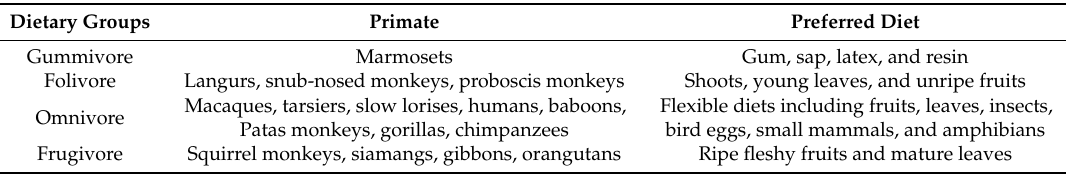
Table 1. Food preferences of primates found mainly in Southeast Asia and Borneo. Dietary